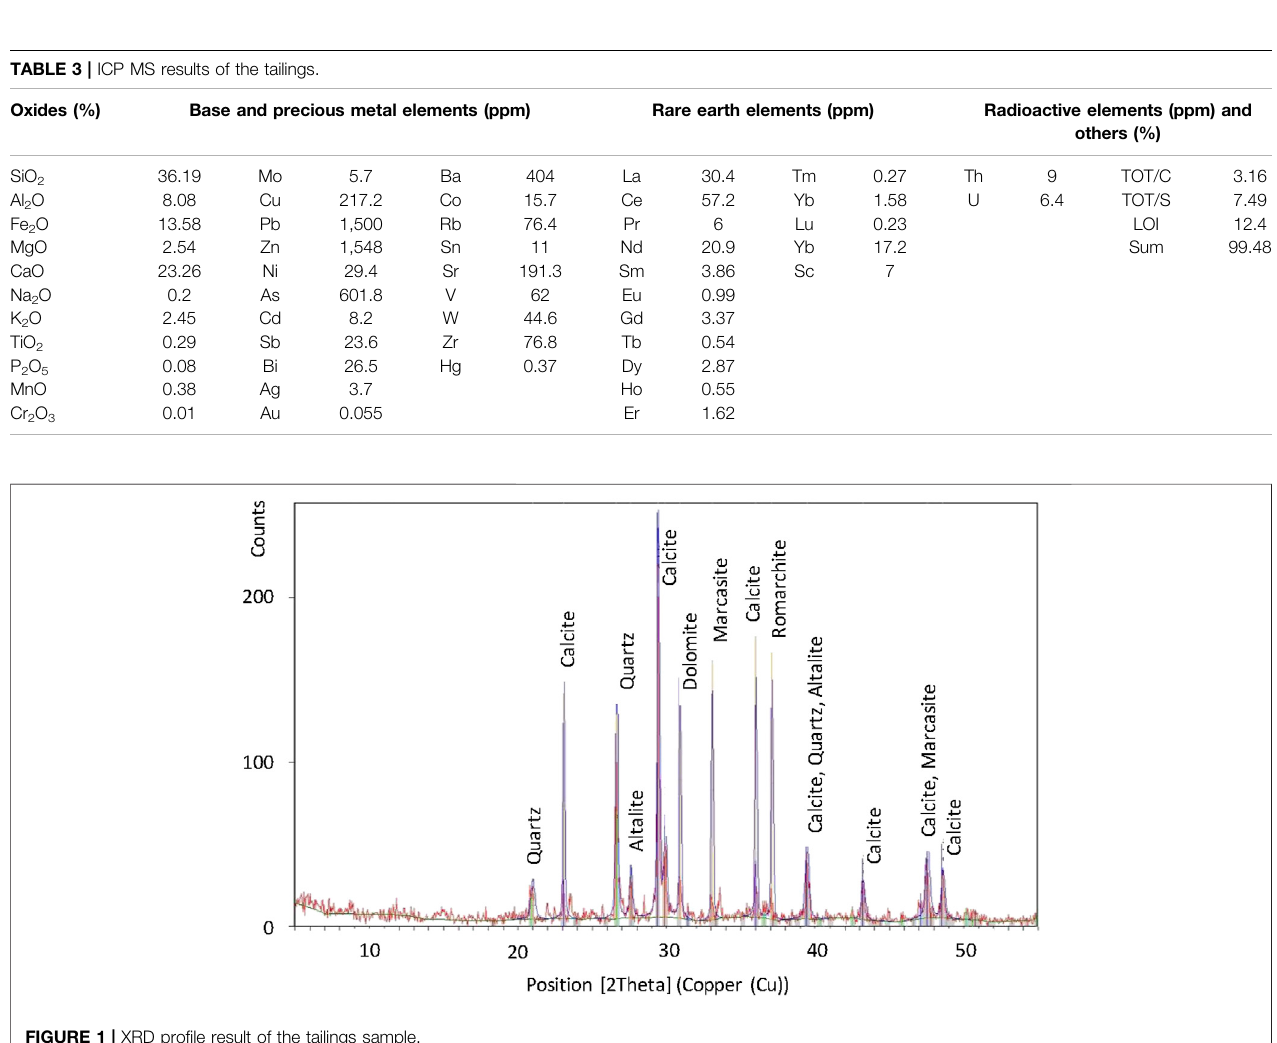
FIGURE 1 | XRD pro fi le result of the tailings